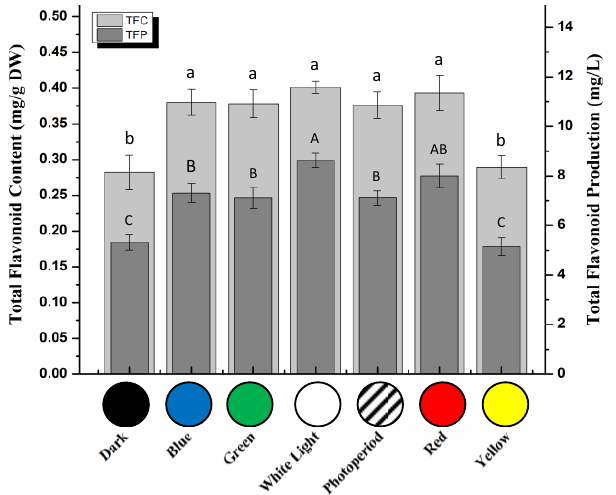
Figure 5. Total flavonoid content (TFC) and total flavonoid production (TFP) in callus cultures kept under different monochromatic lights. Data are expressed in terms of mean ± SD of at least three independent experiments. Different letters indicate significant differences between conditions ( p < 0.05).